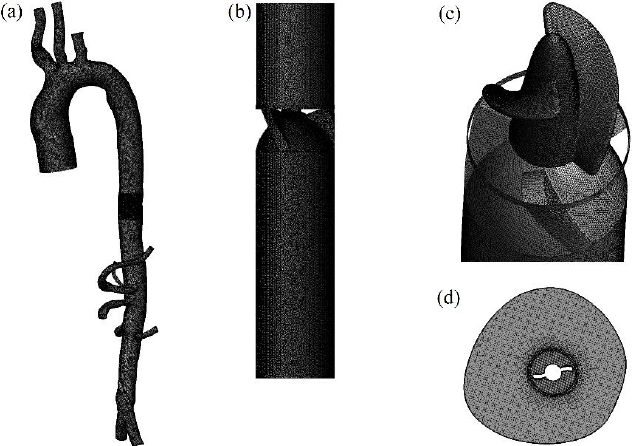
Figure 2. Arterial and studied pump meshes for computational fluid dynamics: ( a ) arterial mesh; ( b ) studied pump mesh; ( c ) studied pump rotor and diffuser mesh; ( d ) cross-sectional mesh of the region where the studied pump was located.